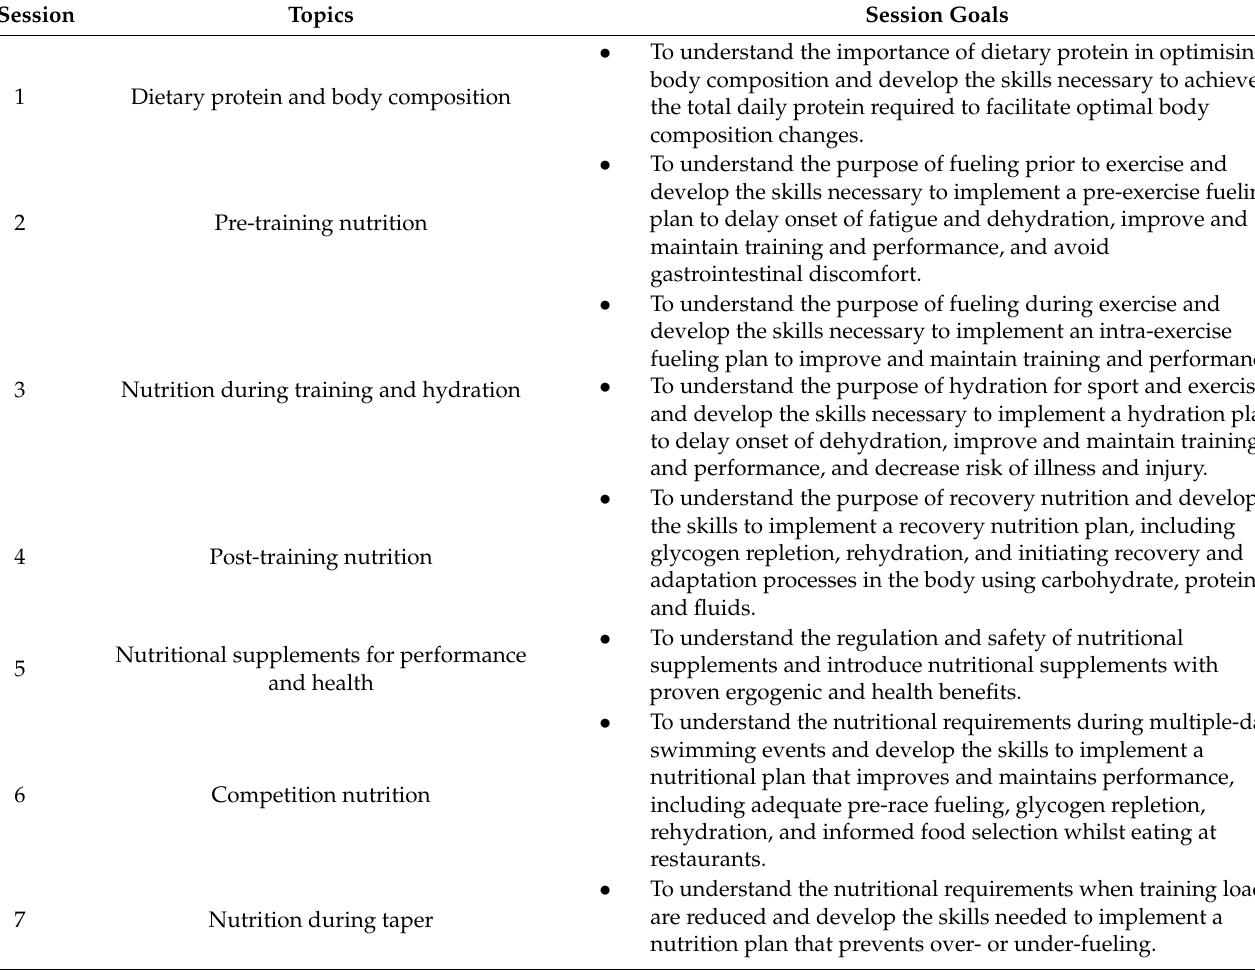
Table 1. Nutrition education intervention